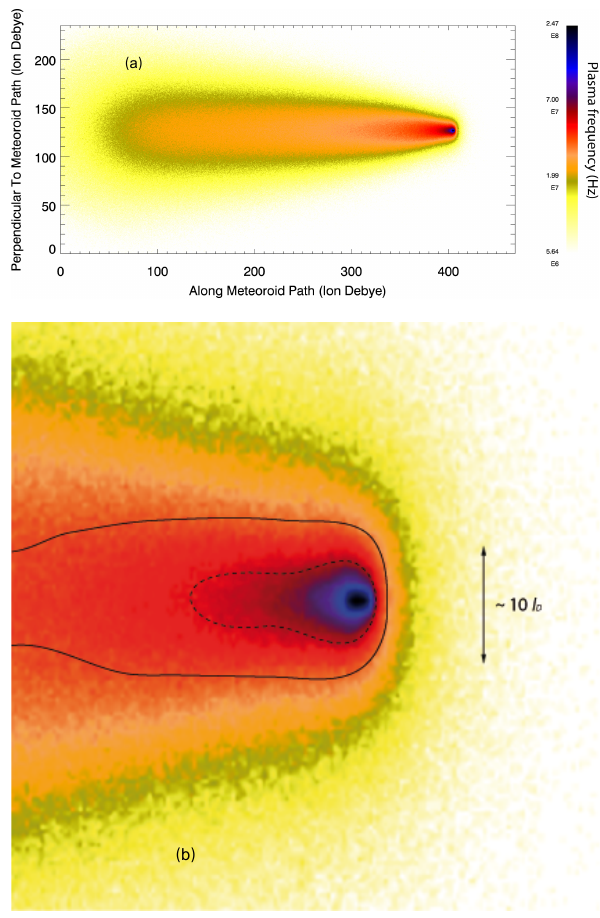
Fig. 8. Results from a simulation of early time meteor plasma, reproduced from Dyrud et al. (2007) by permission. The meteor simulated here was moving against the surrounding atmosphere at 40kms − 1 , i.e. at about the average speed of our event popula- tion, and was producing 10 12 ions/meter. The axes are in units of local ion Debye length l D ; in the ionosphere near 96km al- titude l D is of the order of 0.5...1cm. The electron density n e is represented in terms of equivalent plasma frequency: orange ↔ n e ≈ 5 × 10 13 m − 3 , violet ↔ n e ≈ 6 × 10 14 m − 3 and black ↔ n e ≈ 7 . 5 × 10 15 m − 3 . Part (a) shows the plasma density distribution out to 400 l D behind the meteoroid, while panel (b) is a magnifica- tion of the region in the immediate vicinity of the meteoroid; the full contour line corresponds to n e ≈ 2 × 10 14 m − 3